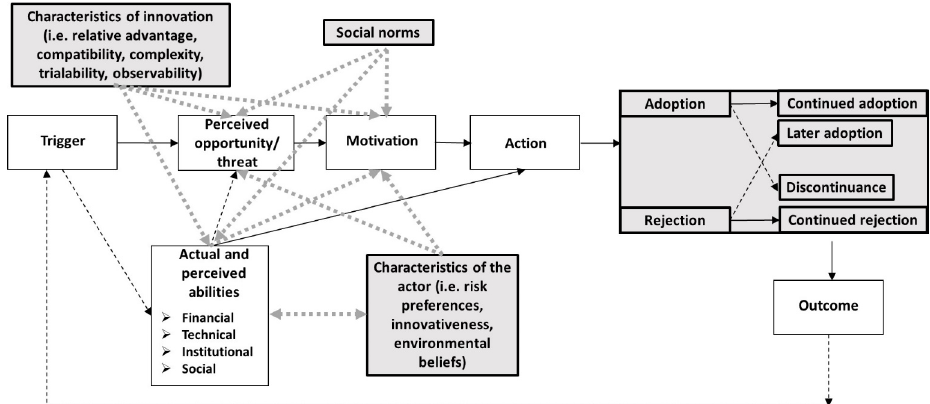
Figure 5. Step 5 of the base model MOTA framework could involve undertaking further insight analysis to strategically untangle the mecha- nisms underpinning the MOTA elements for water resources plans. The further analysis add-ins (in the grey shaded boxes) have been adapted from the Diffusion of Innovations (Rogers, 2010) and theory of planned behaviour (Ajzen, 1991)